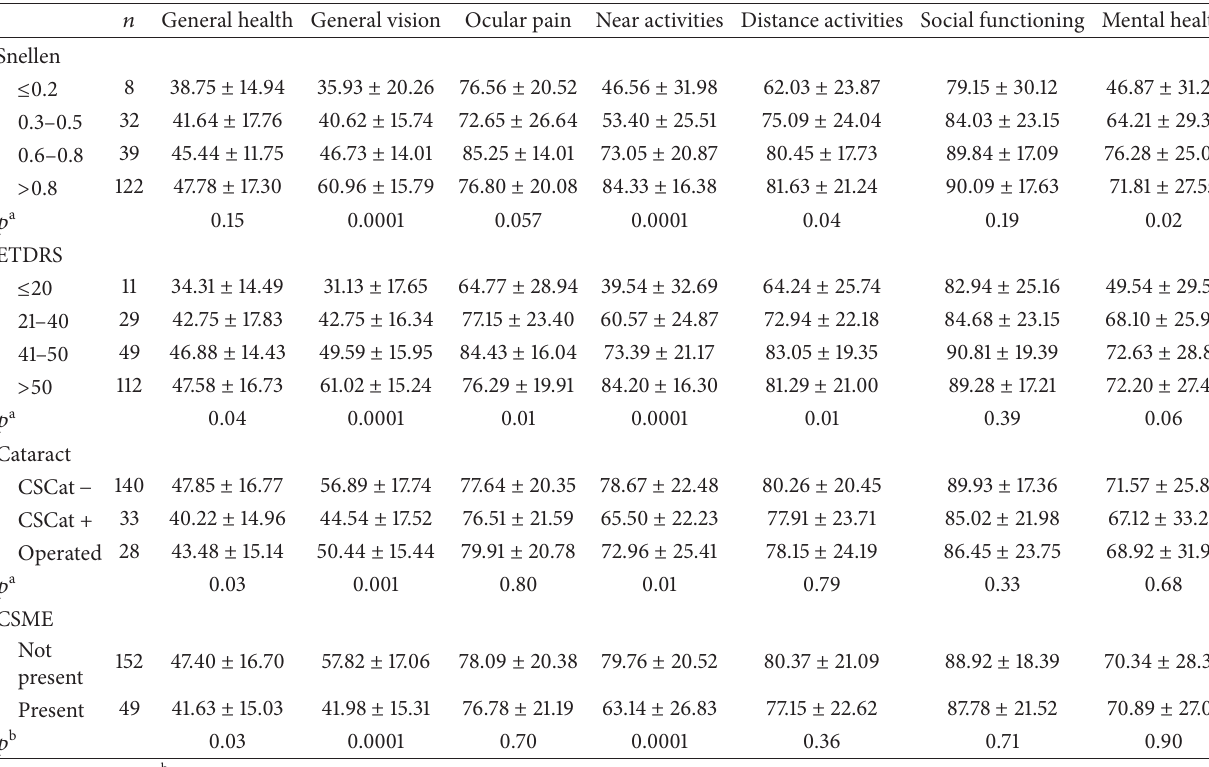
Table 8: Questionnaire scores according to ophthalmologic findings.